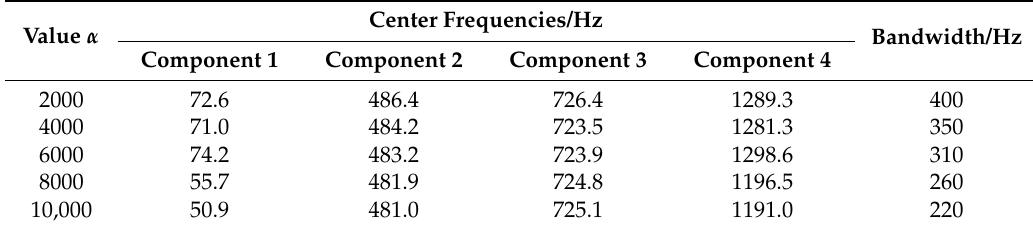
Table 2. Center frequencies and frequency bandwidth under different value α